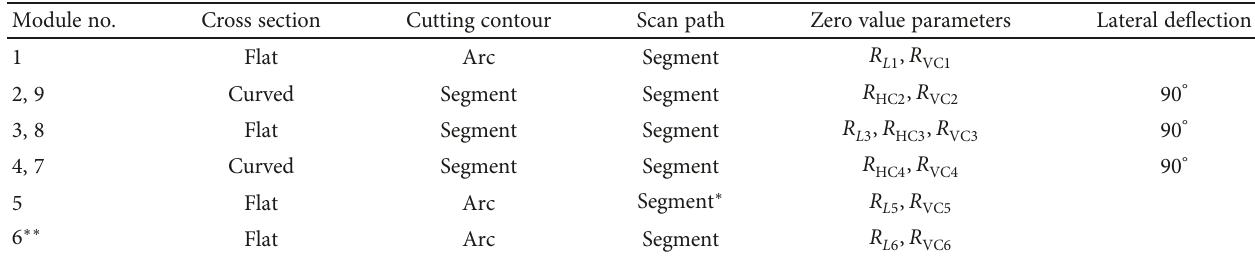
Table 1: Parameter de fi nition of the digging spoon.